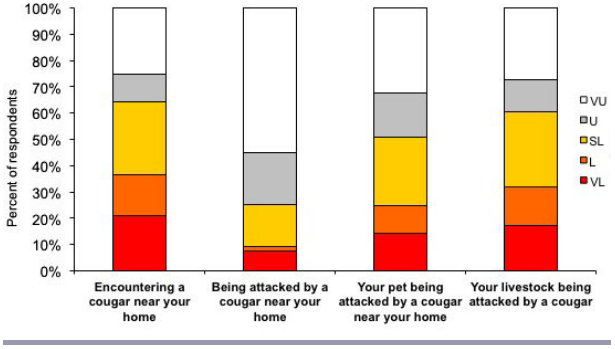
Fig. 3 . The likelihood that respondents to the Clearwater County Cougar Survey believed that they would have an interaction with a cougar near their home. VL = very likely, L = likely, SL = somewhat likely, U = unsure, VU = very unlikely.